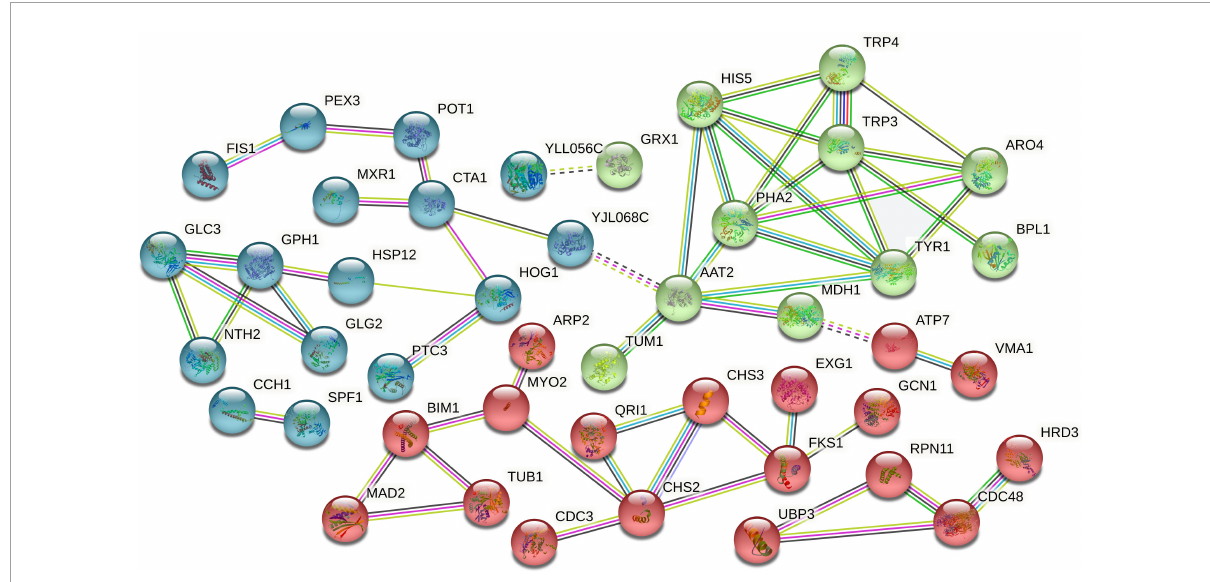
FIGURE5 Protein-protein interaction analysis of dessication-responsive differentially abundant proteins. Different line colors represent the types of evidence used in predicting the associations: gene fusion (red), neighborhood (green), co-occurrence across genomes (blue), co-expression (black), experimental (purple), association in curated databases (light blue), or co-mentioned in PubMed abstracts